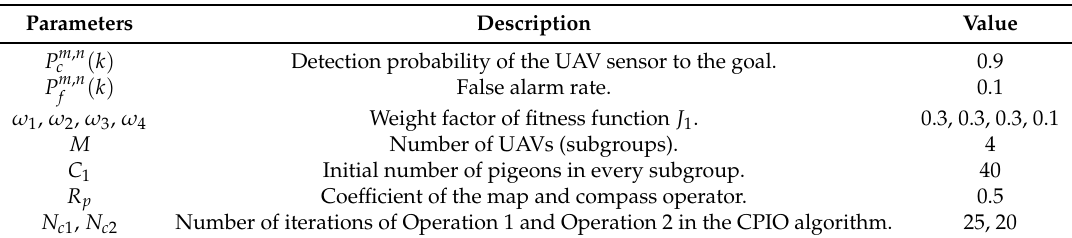
Table 1. Parameters in MUCS.